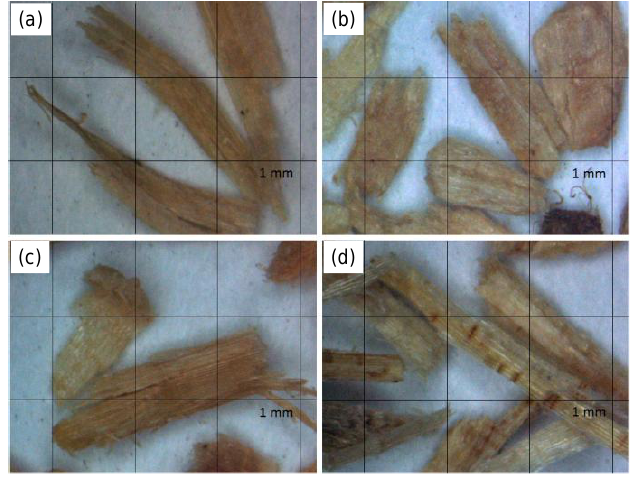
Figure 1. Micrographs of different lignocellulosic fibers: ( a ) makino bamboo; ( b ) India-charcoal trema; ( c ) Taiwan red pine; and ( d ) Chinese fir.